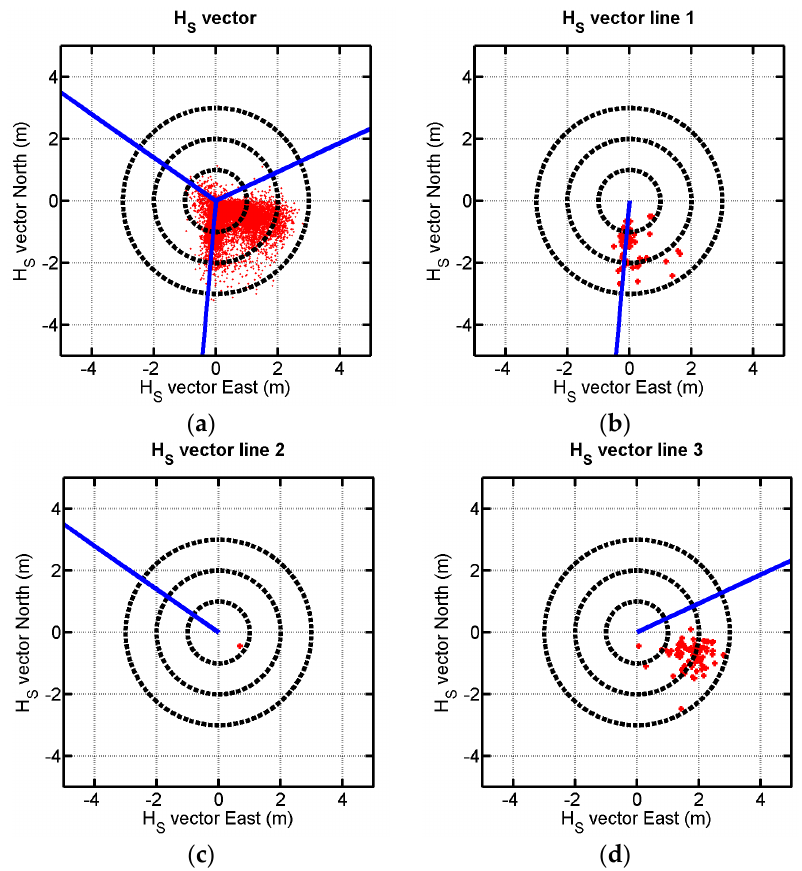
Figure 14. H S vector summarising the amplitude of H S during a sea state and the associated peak wave direction D P (here, the wave direction is the incoming direction) ( a ) for the general wave conditions and for the sea states associated with peak mooring loads on mooring lines ( b ) 1, ( c ) 2 and ( d ) 3.